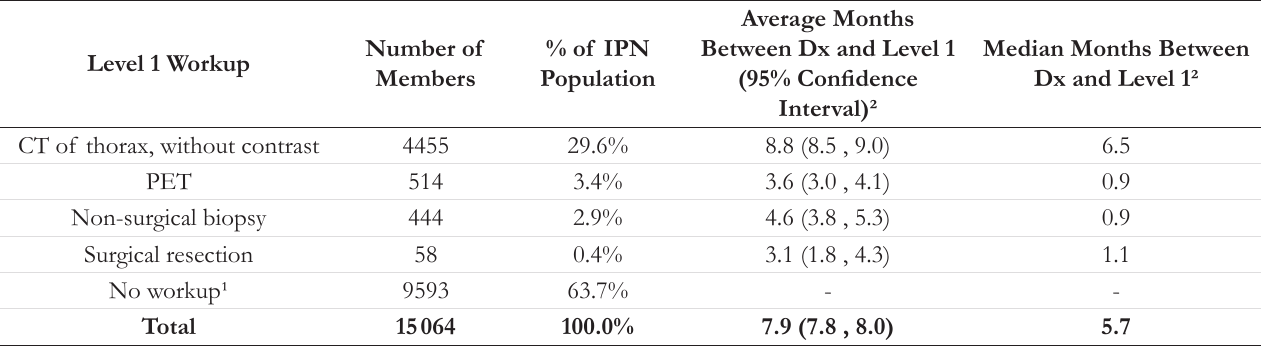
Table 4. Time Between Diagnosis and